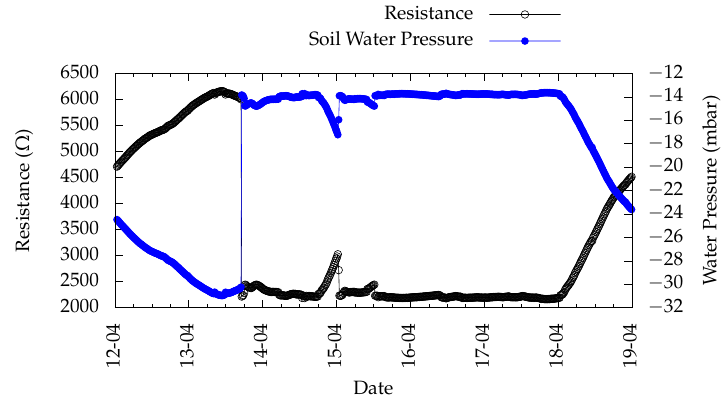
Figure 12. Output data from the Watermark sensor.